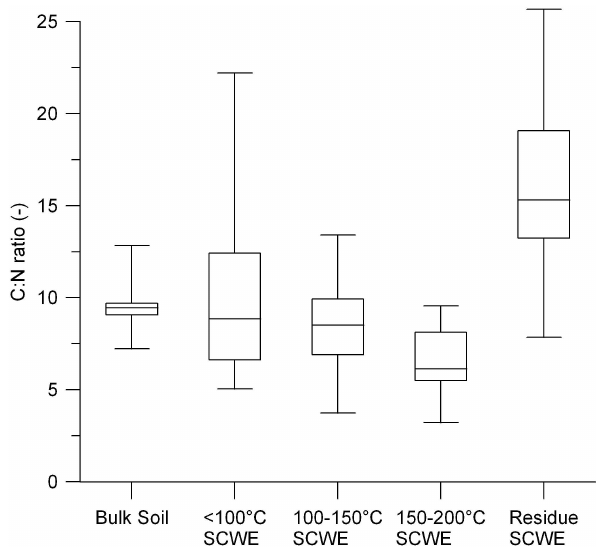
Fig. 3. Average C:N ratios of the bulk soil, subcritical water ex- tracts and the extraction residue ( n = 25, error bars show standard deviations).